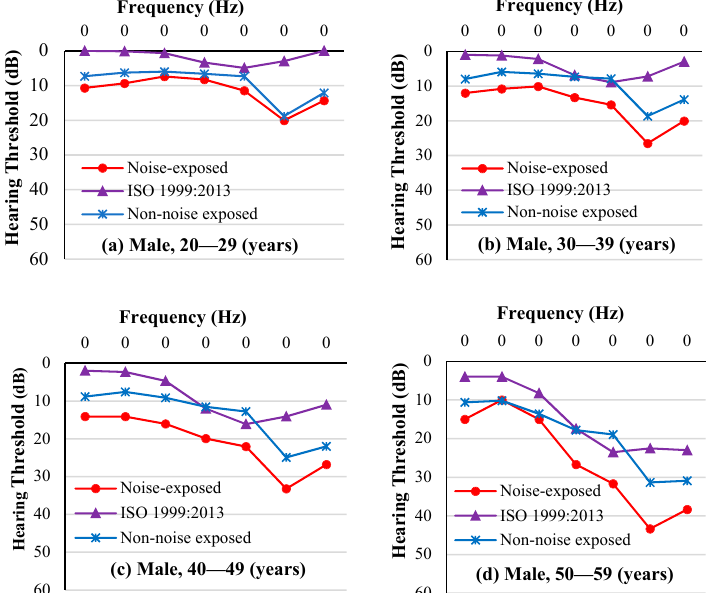
Figure 5. Comparison between the average hearing thresholds (HTs) of noise-exposed male workers, ISO-estimated median HTs of noise-exposed male workers, and the average HTs of non-noise-exposed